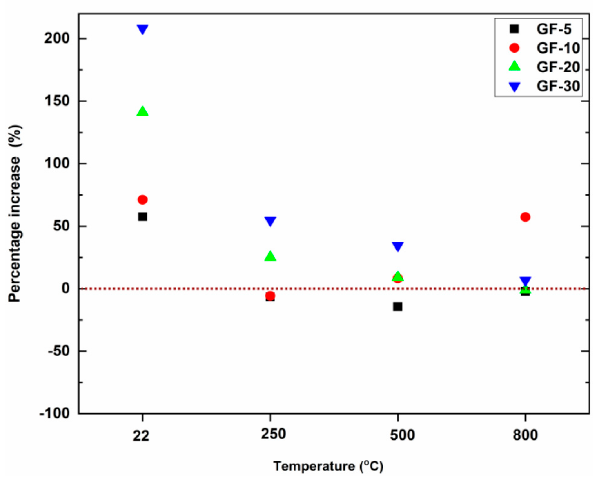
Figure 10. Compressive strength comparison of composite foams with pure foam samples (dotted line).